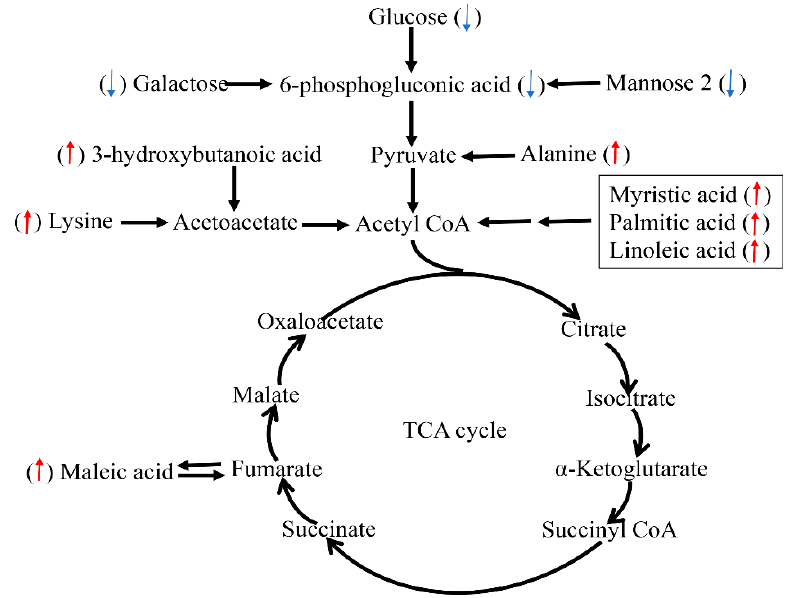
Figure 5. Schematic overview of some important metabolites and major metabolic pathways related to fat acid, amino acid, and energy metabolism in heat-stressed pigs. Red up-arrow: heat stress (HS) group vs. thermal neutral (TN) group up-regulation. Blue down-arrow: HS group vs. TN group down-regulation.